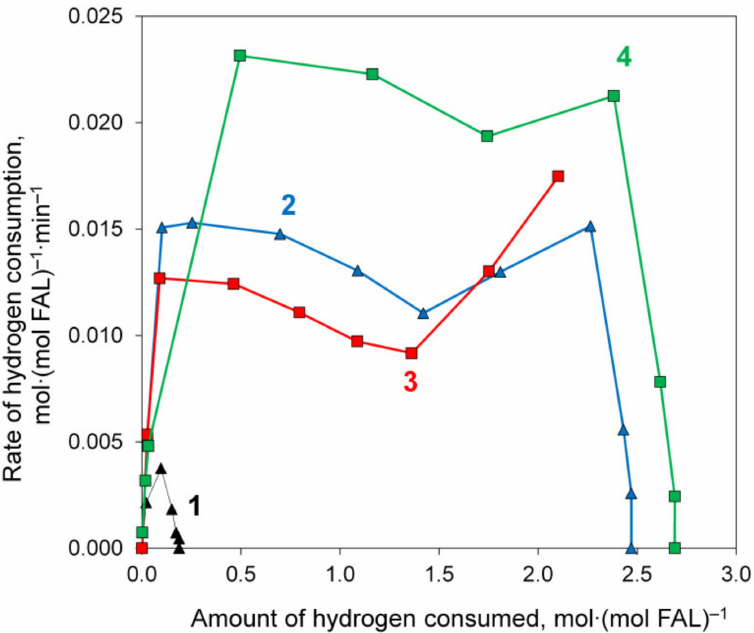
Figure 10. Rate of hydrogen consumption plotted vs. amount of hydrogen consumed during aqueous- phase hydrogenation of FAL at 150 ◦ C and 3.0 MPa in the presence of Ni@NiAlO x -2-500 (line 1), Ni@NiAlO x -4-500 (line 2), Ni@NiAlO x -2-600 (line 3), and Ni@NiAlO x -4-600 (line